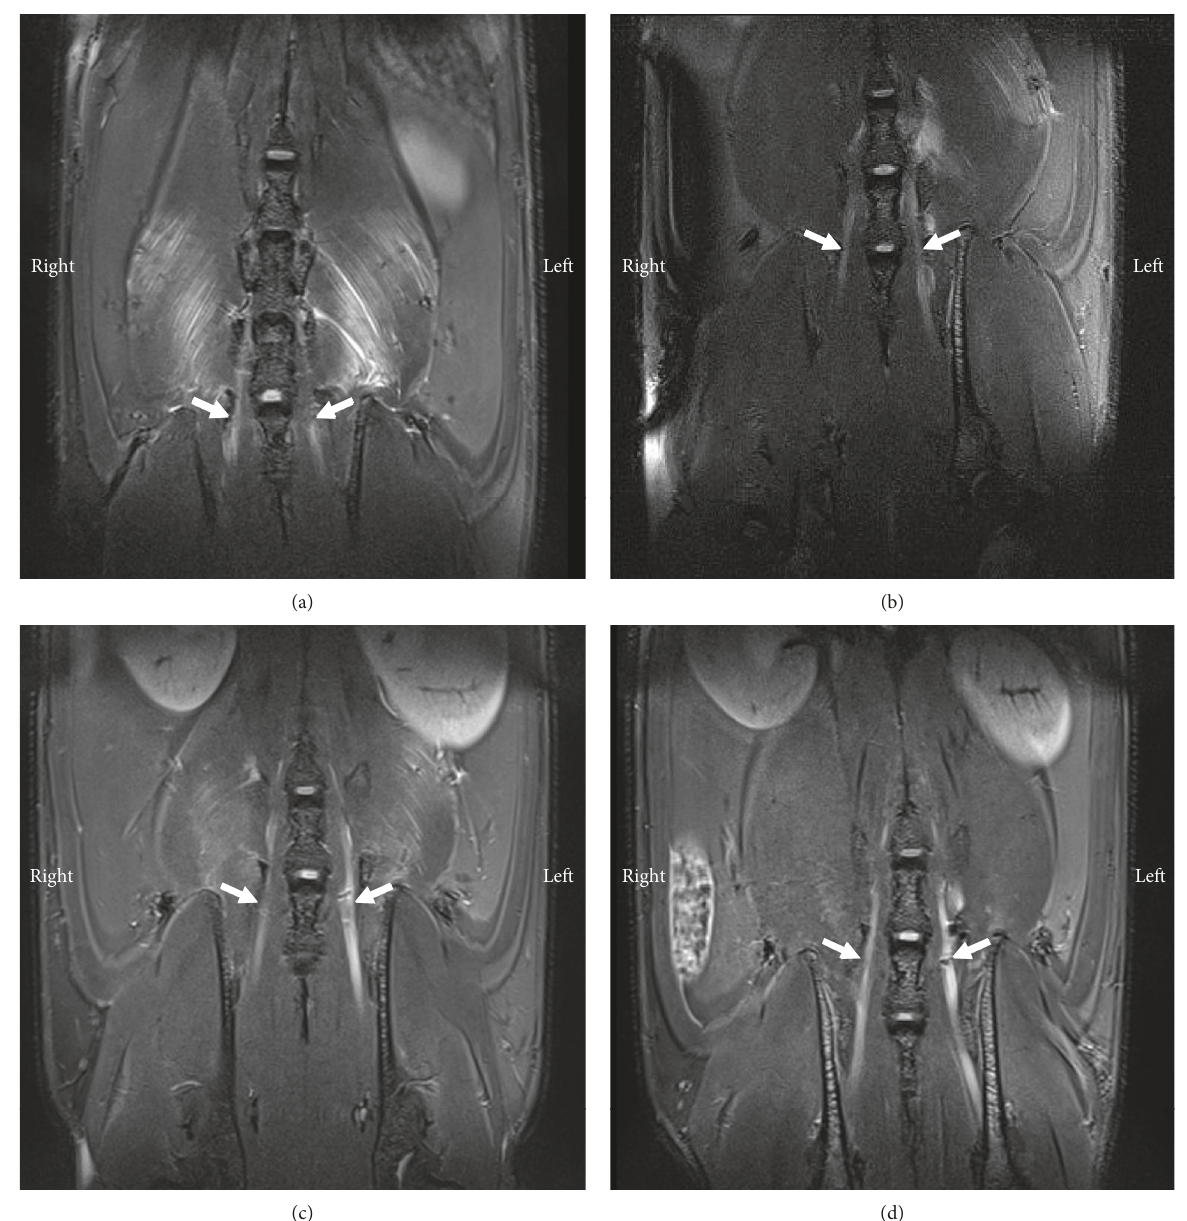
Figure 6: Coronal T2-WI a day after intrathecal injection of MMP-12-targeted probe. White arrows indicate left and right L5 spinal nerves, in sham and SNL rats ( n � 2 per group). Compared to uninjured nerves, injured nerves are enlarged, and iron-induced signal loss is observed at the approximate site of ligation. (a) Sham 1. (b) Sham 2. (c) SNL 1. (d) SNL